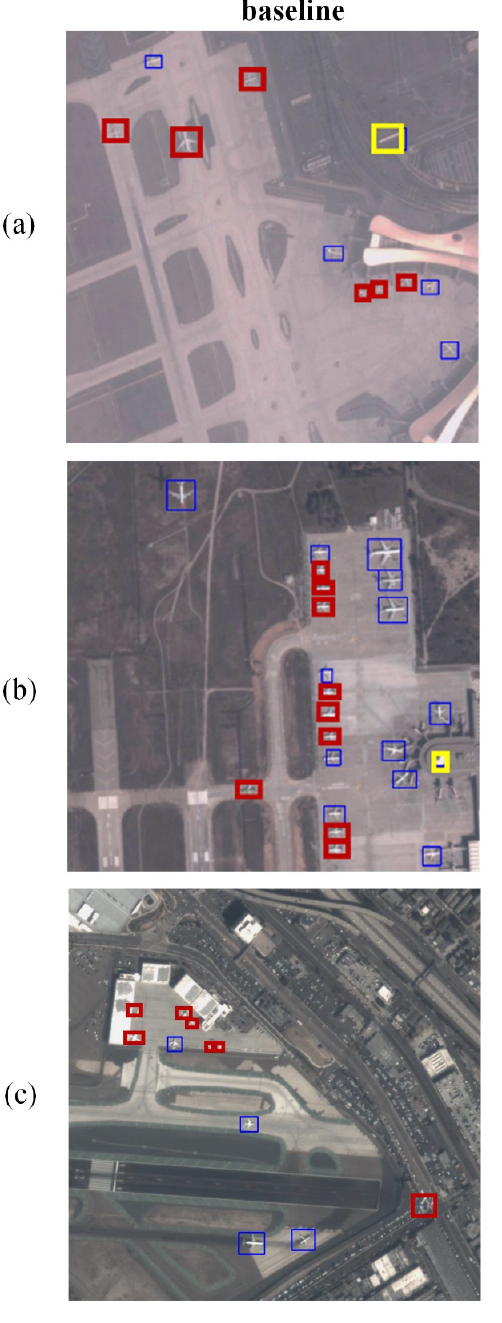
Figure 6. Visualization comparison between the proposed method and the baseline in ( a ) low contrast, ( b ) dense distribution, and ( c ) complex background scenarios (green, blue, red, and yellow represent the results of the proposed method, the results of the baseline, missed detection, and false detection, respectively).